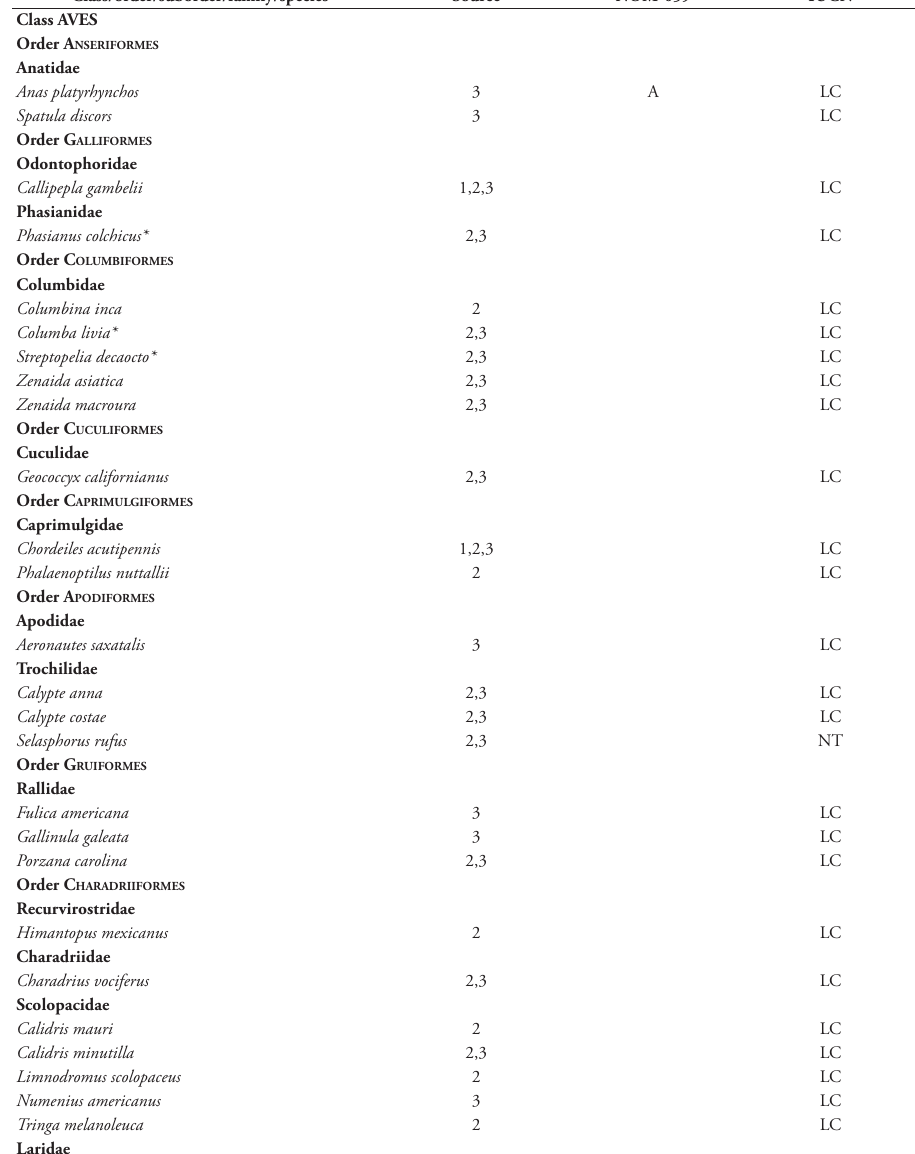
Table 1. List of species and conservation status of birds, mammals and reptiles of Cucapá. The source of record: 1 = GBIF with collected specimens, 2 = iNaturalist and eBird observations (the second, only for birds), 3 = fieldwork. The risk extinction categories from NOM-059-SEMARNAT-2010 are A = Threat- ened, Pr = Subject to Special Protection, P = Endangered, E = Probably Extinct in the Wild. The risk ex- tinction categories from the IUCN Red List are: LC = Least Concern, NT = Near Threatened, VU = Vul- nerable. * = exotic